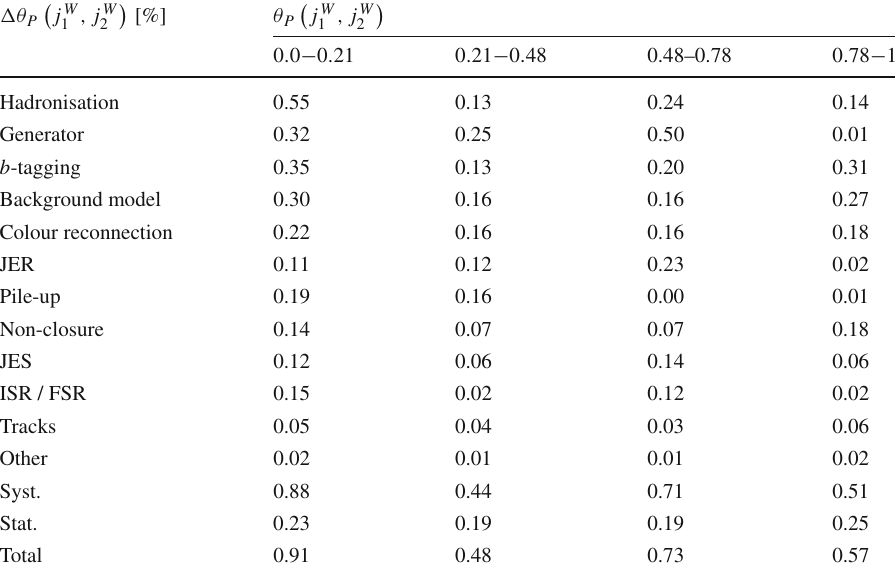
systematic uncertainties affecting the measurement of (cid:4) (cid:5) θ P , j W j W . The category 1 2 “Other” summarises various smaller uncertainty